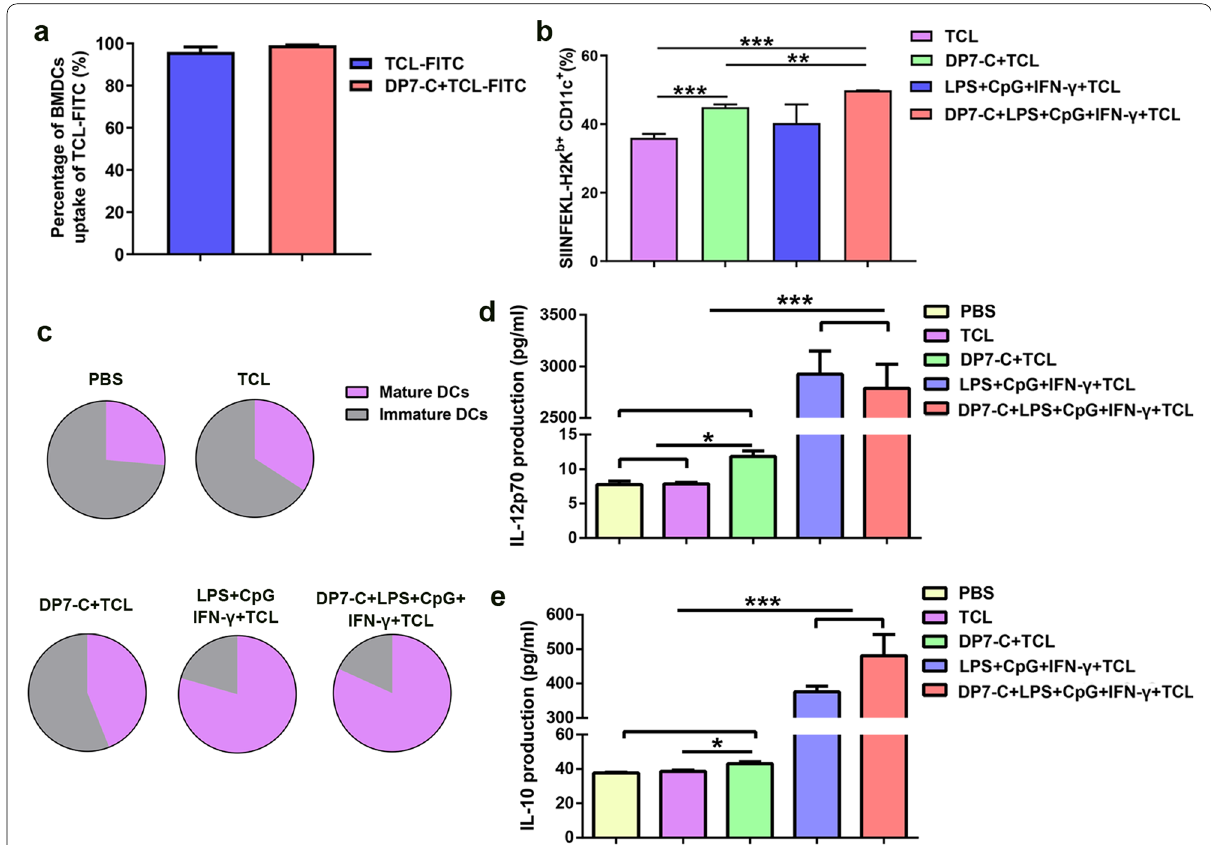
Fig. 2 The efficiency of the antigen uptake and presentation of DCs, the maturation of DCs, and the secretion of cytokines by DCs after treatment. a . The uptake efficiency of DCs in FITC-labeled whole-tumor lysates. b . The EG7-OVA presentation efficiency of DCs from whole-tumor lysates stained with the monoclonal antibody 25-D1.16, which recognizes the OVA 257–264 -H-2Kb complex. c . Percentage of mature DCs among all DCs after different treatments. d . Detection of IL-12p70 in culture supernatants by ELISA after different treatments. e . Detection of IL-10 in culture supernatants by ELISA after different treatments. Significance was calculated using a one-way ANOVA with multiple comparisons tests. (* p < 0.05, ** p < 0.01, *** p <